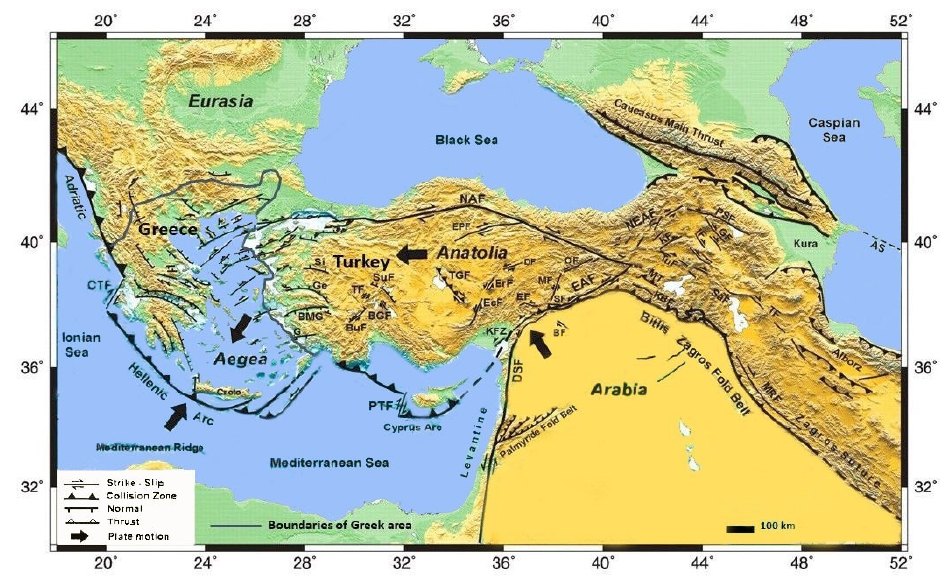
Figure 4. Sketch map depicting the geodynamic setting of Greece ([64], modified by us). Although the Aegean region is characterized by extensional tectonics, resulting in a steady subsidence, the Hellenic Arc has an elevated position relative to the Cretan Sea in the north (Figure 5). Angelier and Le Pichon [64], Angelier [65], Le Pichon and Angelier [66], and Angelier et al. [56] attributed this uplift of the Hellenic Arc to a mechanism of crustal underplating, at least since the Middle Miocene. This would mean that sediments were removed from the subducting plate (African) to form the new basement of the Hellenic Arc